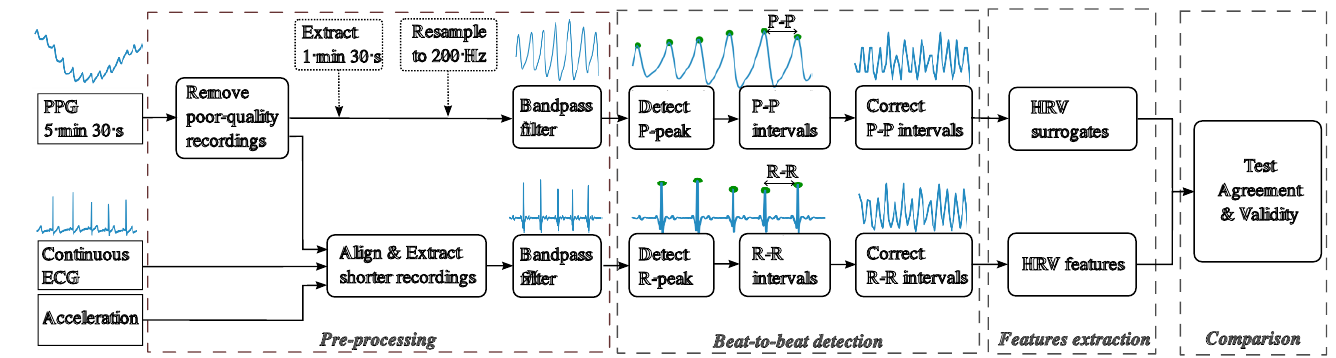
Figure 2. Block diagram of the proposed approach.